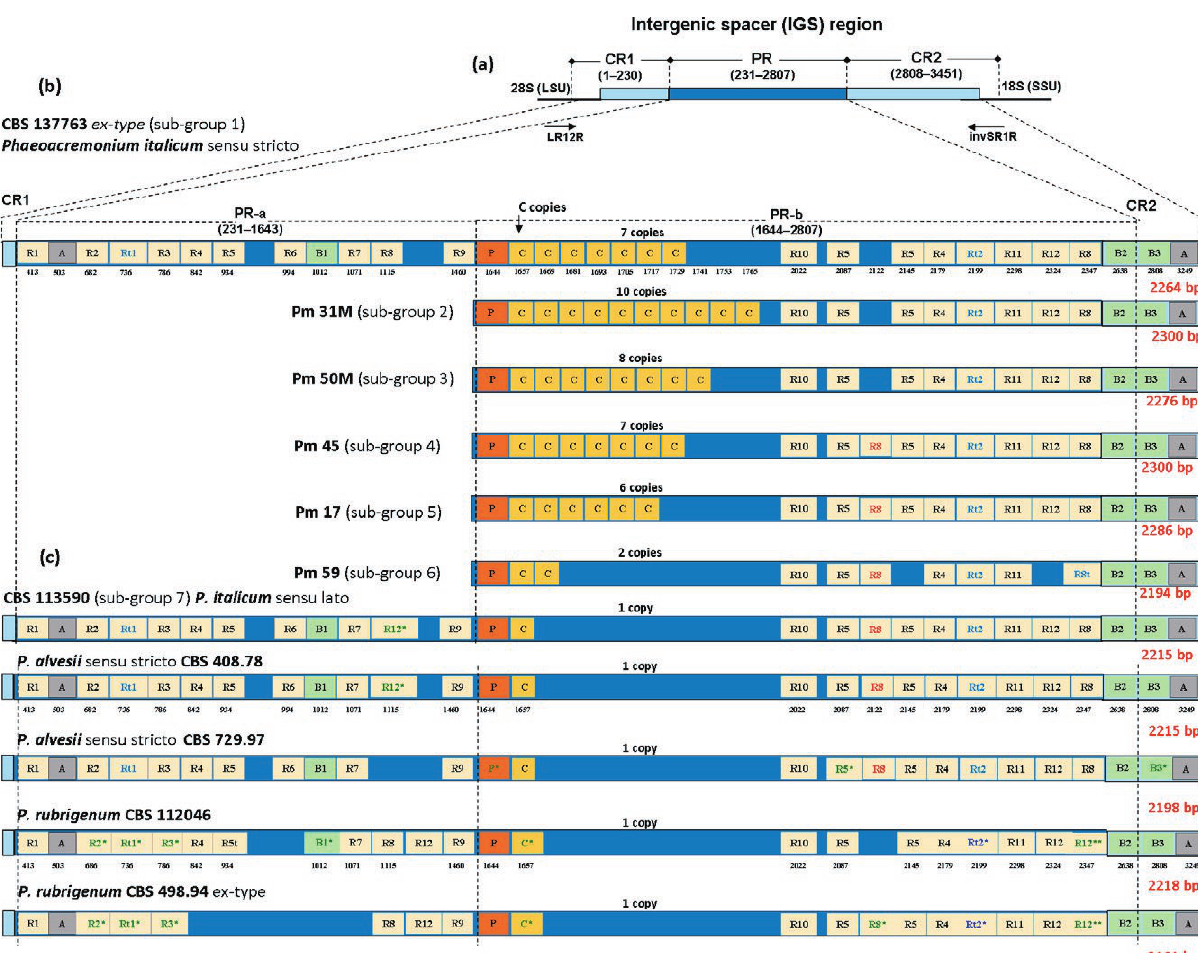
Figure 1. Structures of the IGS rDNA regions in Phaeoacremonium italicum , P. alvesii and P. rubrigenum . (a) Organisation of the IGS rDNA sequences into sub-regions CR1 (conserved region), PR (polymorphic region) and CR2 (conserved region), with corresponding nucleotide positions in parentheses. Arrows indicate annealing positions of PCR universal primers LR12R and invSR1R, within the extremities of the 28S and 18S rRNA genes. (b) Structural organisation of repeat elements A, B, C, P and R in the IGS region of P. italicum sub-groups #1 to #6. Numbers below indicate nucleotide bp of start positions of each element. (c) Structural organisation of repeat elements in the IGS region of P. italicum sub-group #7, P. alvesii and P. rubrigenum strains. Numbers below indicate nucleotide bp of start positions of each element. (b and c) Areas CR1 and CR2 are not shown because they have the same structural organisation in all of the isolates. Sub-region PR-b shares a structural organisation of five short repeat elements (A, B, C, P, R) in all of the isolates that are differently located on the basis of each sub-group